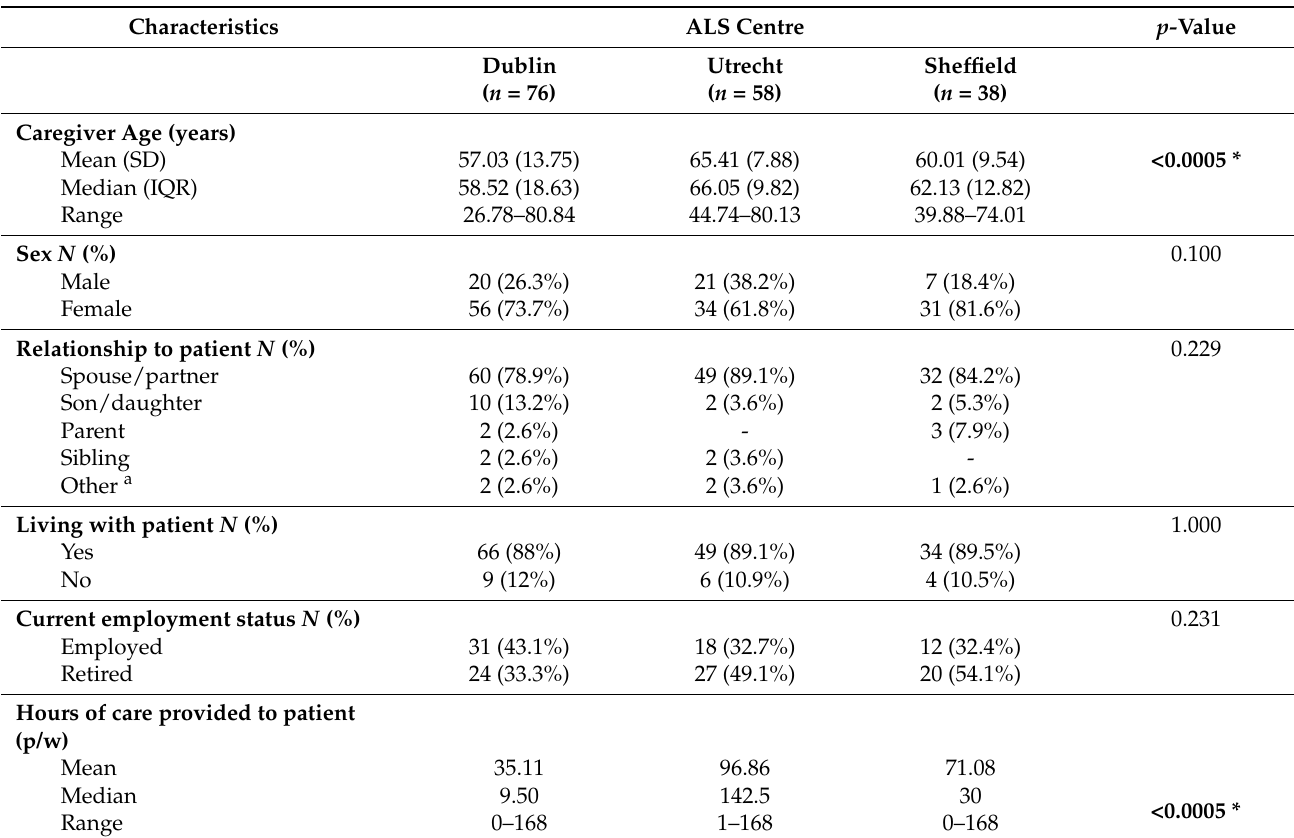
Table 1. Caregiver